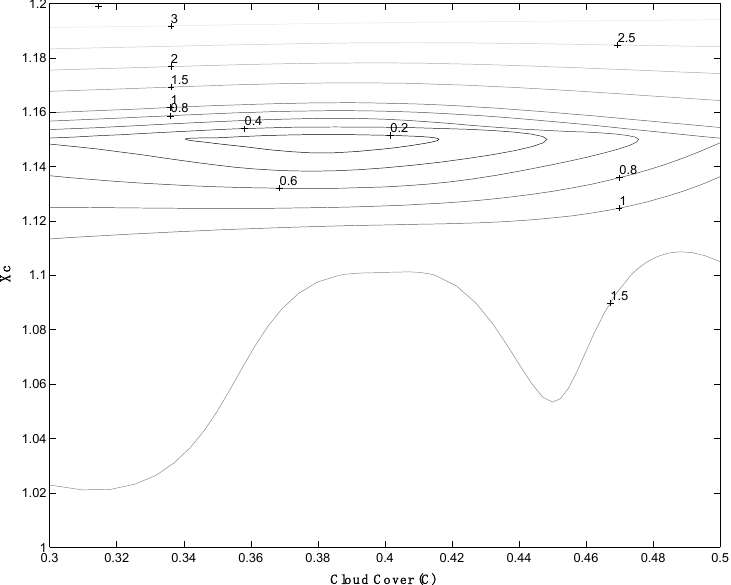
Figure 6. Model Response Map for calibration of cloud cover C and factor X c (contour levels represent deviation between simulated and observed lake water level).